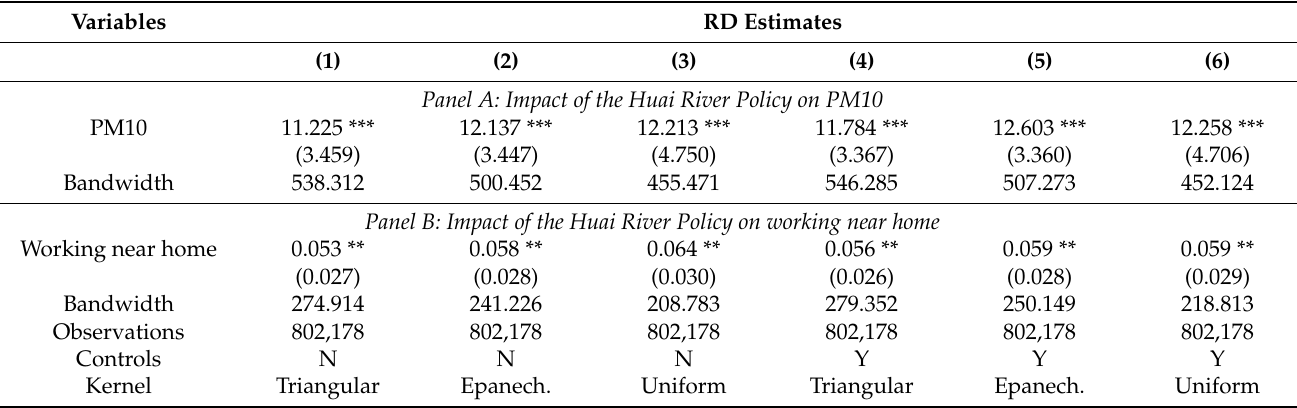
Table 2. RD estimates of the impacts of the Huai River